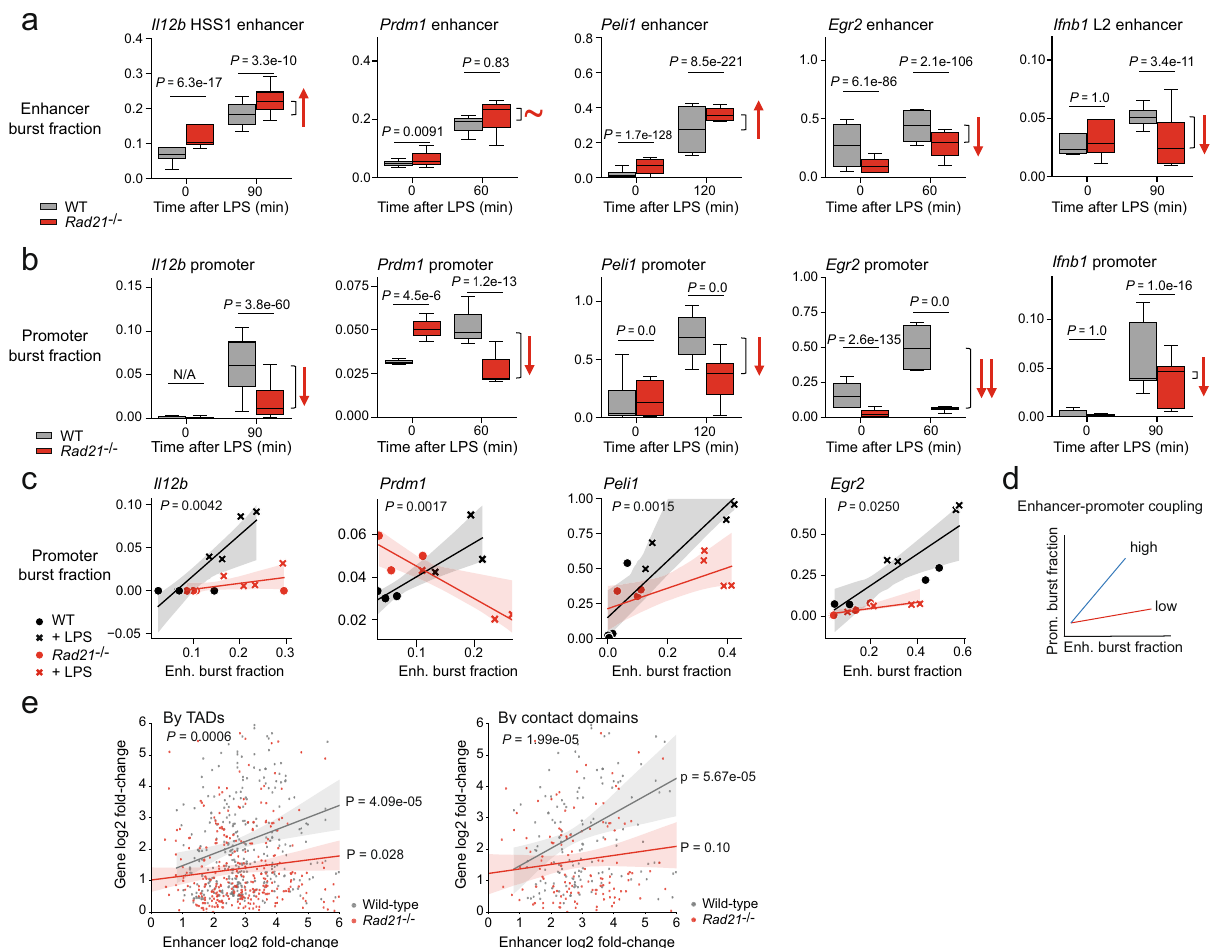
Fig. 7 Cohesin couples transcriptional burst fractions of inducible genes and inducible enhancers. a Transcriptional burst fractions of the indicated enhancers in wild-type (grey) and Rad21 − / − macrophages (red). N = 135,185 cells, four independent biological replicates. b Transcriptional burst fractions of the indicated promoters in wild-type (grey) and Rad21 − / − macrophages (red). N = 135,185 cells, four independent biological replicates. c Transcriptional burst fractions of the indicated promoters and enhancers in wild-type (grey) and Rad21 − / − macrophages (red). Statistical test for the interaction: two-way ANOVA, two-sided (design formula: burst fraction gene ∼ burst fraction enhancer*Genotype), P values < 0.05 indicate that the relationship between enhancer and promoter burst fractions is different between Rad21 − / − and wild-type macrophages. N = 135,185 cells, four independent biological replicates. Error bands: 95% con fi dence interval. d Schematic: Relationship between transcriptional burst fractions of inducible genes and inducible enhancers. e Correlation between the LPS-induced transcription of inducible enhancers (GRO-seq enhancer log2 fold-change 1 h after LPS) and the transcription of protein-coding genes located in the same TADs (left) or contact domains (right) as the enhancers (RNA-seq gene log2 fold-change 2 h after LPS) in wild- type (grey) and Rad21 − / − macrophages (red). For TADs and contact domains with more than one enhancer, the mean fold-change is shown. TADs: Pearson correlation wild-type = 0.22, P = 4.09e-05. Pearson correlation Rad21 − / − = 0.12, P = 0.028. Two-way ANOVA Enhancer log2 fold- change:Genotype P = 0.00061. Contact domains: Pearson correlation wild-type = 0.32, P = 5.67e-05. Pearson correlation Rad21 − / − = 0.14, P = 0.10.